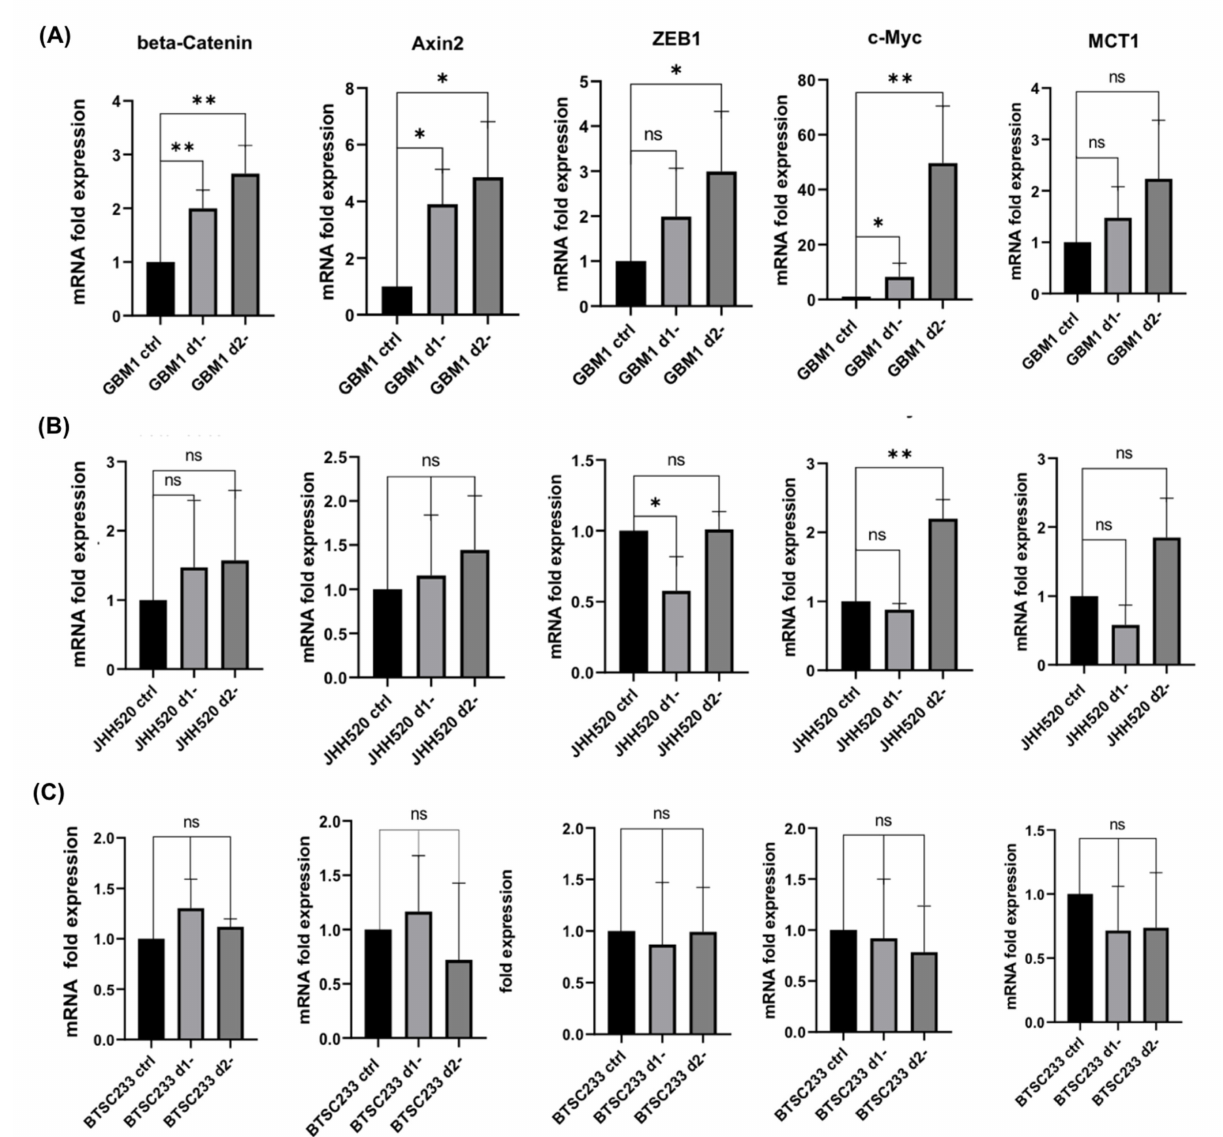
Figure 2. Differential mRNA expression of CTNNB1 and β -catenin target genes in glucose-starved GSCs. ( A – C ) Differential mRNA expression of β -catenin and downstream genes of WNT